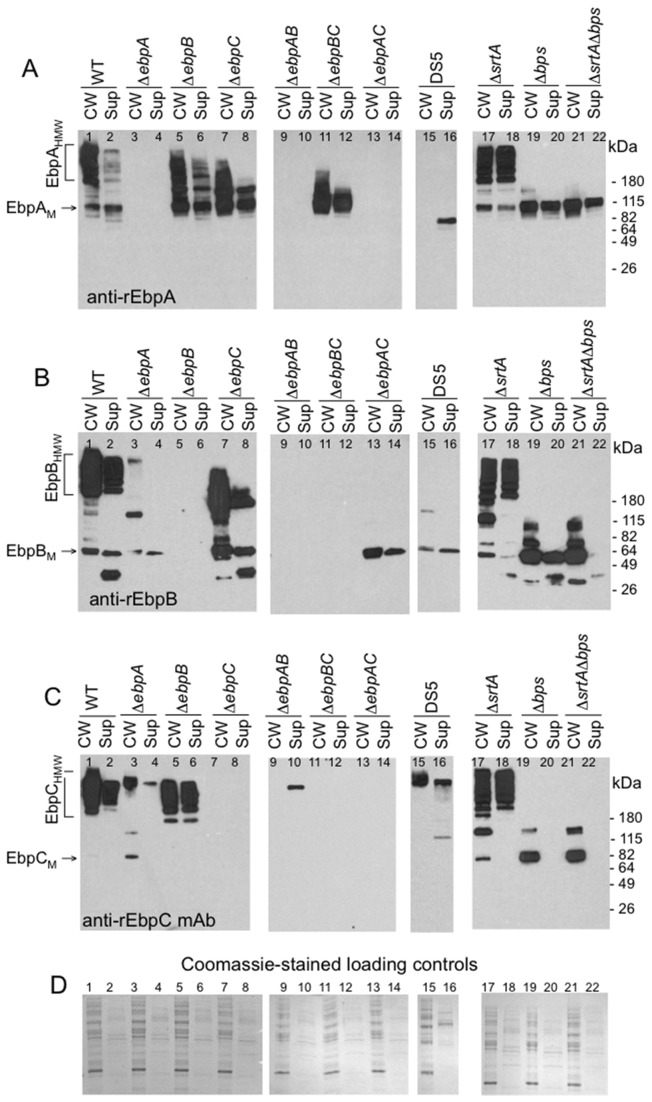
Ebp production by E. faecalis OG1RF, its ebp and sortase mutants, and strain DS5.Western blots of mutanolysin cell wall extracts (CW) and culture medium supernatants (Sup) from exponential phase cultures. (A) Immunoblot stained with polyclonal anti-EbpA antibodies. (B) Immunoblot stained with polyclonal anti-EbpB antibodies. (C) Immunoblot stained with monoclonal anti-EbpC antibodies. (D) Coomassie staining of the above CW and Sup samples; sample order as in panels A, B and C. EbpAM, EbpA monomer; EbpAHMW, high molecular weight EbpA polymers. Positions of molecular weight markers are indicated (For lag phase, see Figure S3).